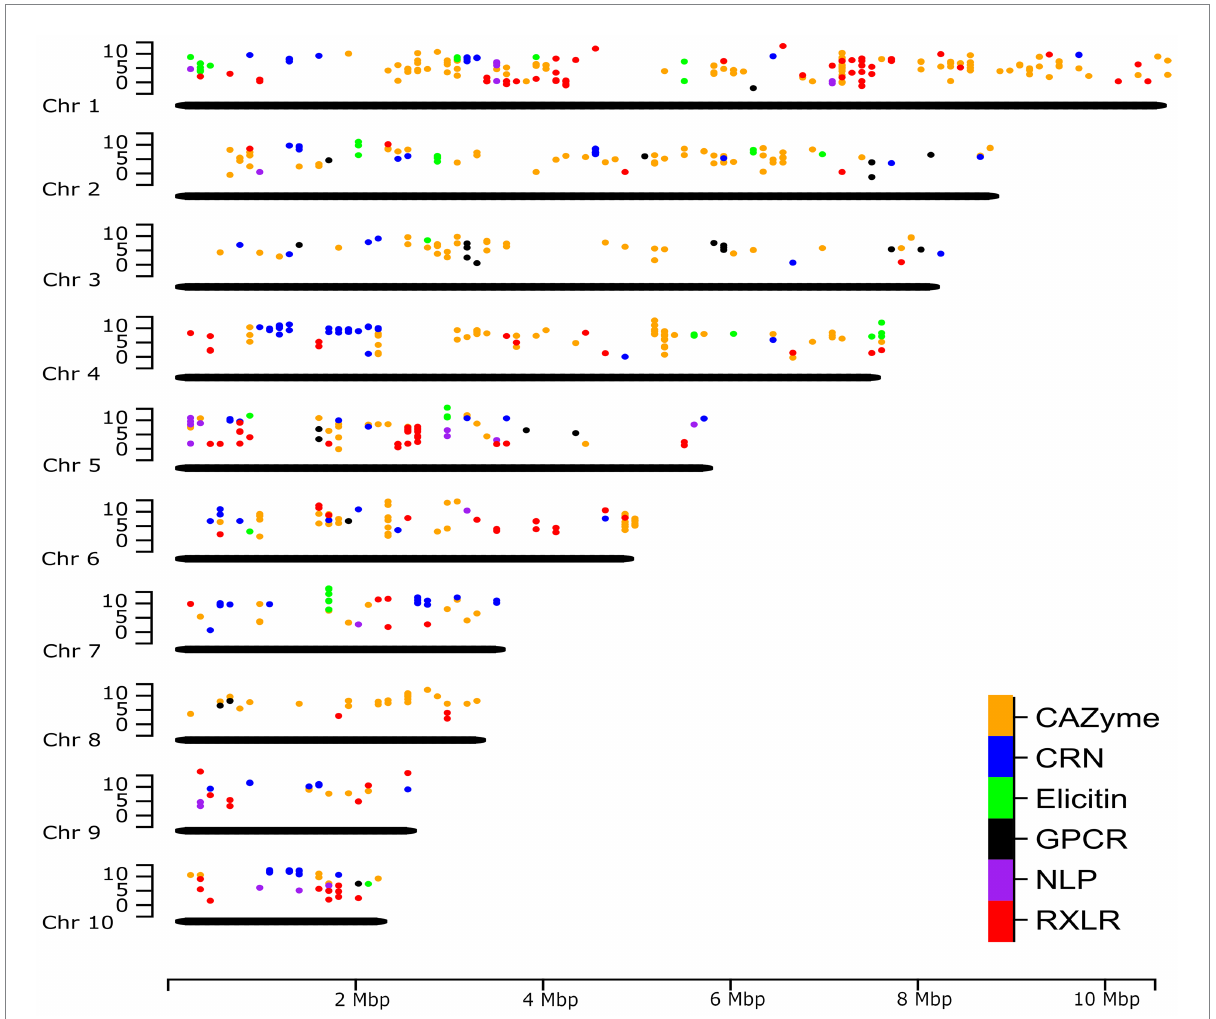
FIGURE 6 Genome-wide expression of putative effectors and other key gene classes. The positions of genes in six key gene classes in the P. agathidicida 3770 genome and the maximum expression value (log 2 fragments per kilobase of exon per million mapped fragments [FPKM]) of those genes across a time course of expression on kauri roots at 6, 24, 48 and 72 h post-inoculation. Chr,